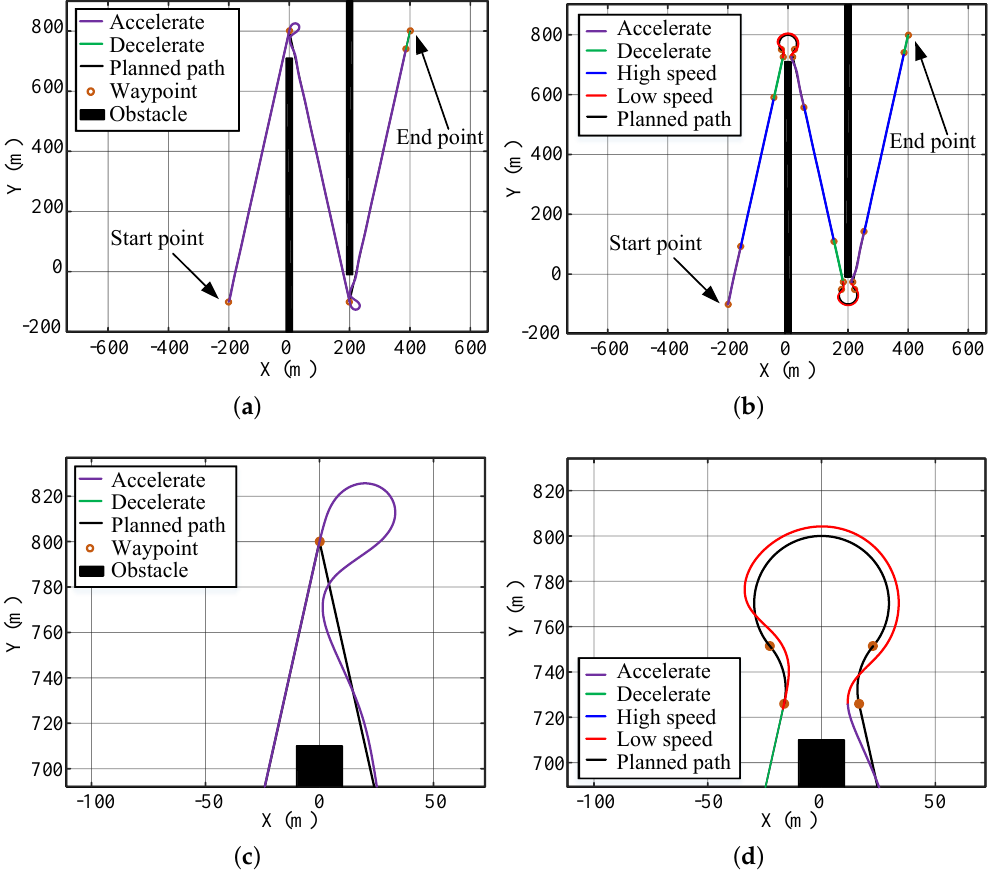
Figure 12. Simulation of large-angle turning tracking scene: ( a ) Original path-tracing results. ( b ) Optimized path-tracing results. ( c , d ) Enlarged partial views of the paths for the turns in ( a , b ). For tasks with less demands on small path deviation and turning safety but more on small travelling time, the weight factors in (1) should be readjust to have large λ 2 and small λ 1 . In this case, the resulted turning radius would be small, and the turning speed would be large using the IPT method. However, the authors do not recommend high-speed turning considering the risk of